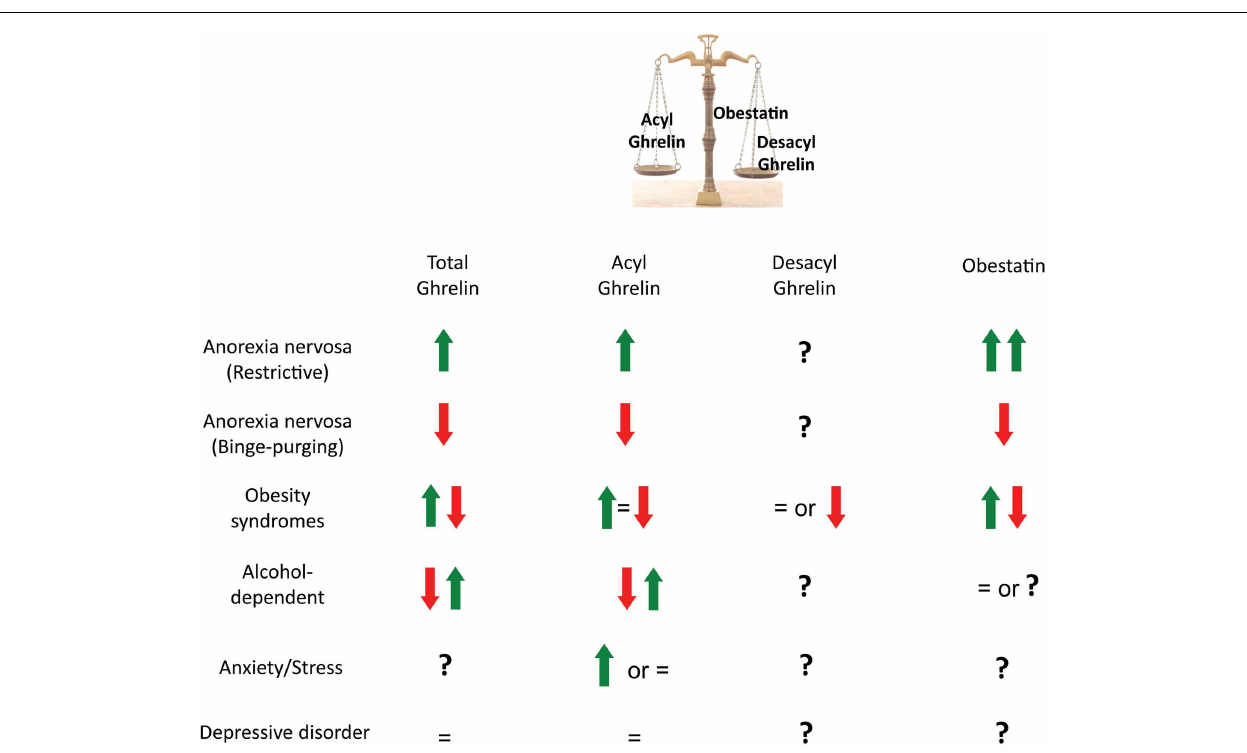
FIGURE 2 | Plasma levels of preproghrelin-derived peptides in metabolic and psychiatric disorders . In anorexic patients, total ghrelin, acyl ghrelin, and obestatin are increased in the restrictive type and reduced in binge-purging.This may represent different abilities to adapt to starvation. In obesity syndromes, total ghrelin, acyl ghrelin and obestatin are either found reduced, unchanged, or increased. Discrepancies may be due to the variety of obesity syndromes (monogenic obesity, nutritionally induced obesity, presence of a metabolic syndrome, multifactorial disorders such as the Prader-Willi syndrome). In alcohol-dependent patients, ghrelin is found